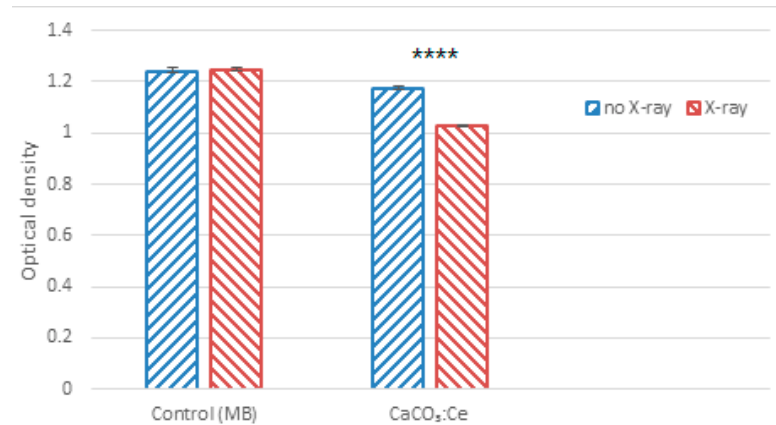
Figure 5. The generation of ROS of CaCO 3 :Ce particles under X-ray irradiation determined by the degradation of methylene blue ( t -test, mean ± SD, n = 6, ****: p -value < 0.0001).